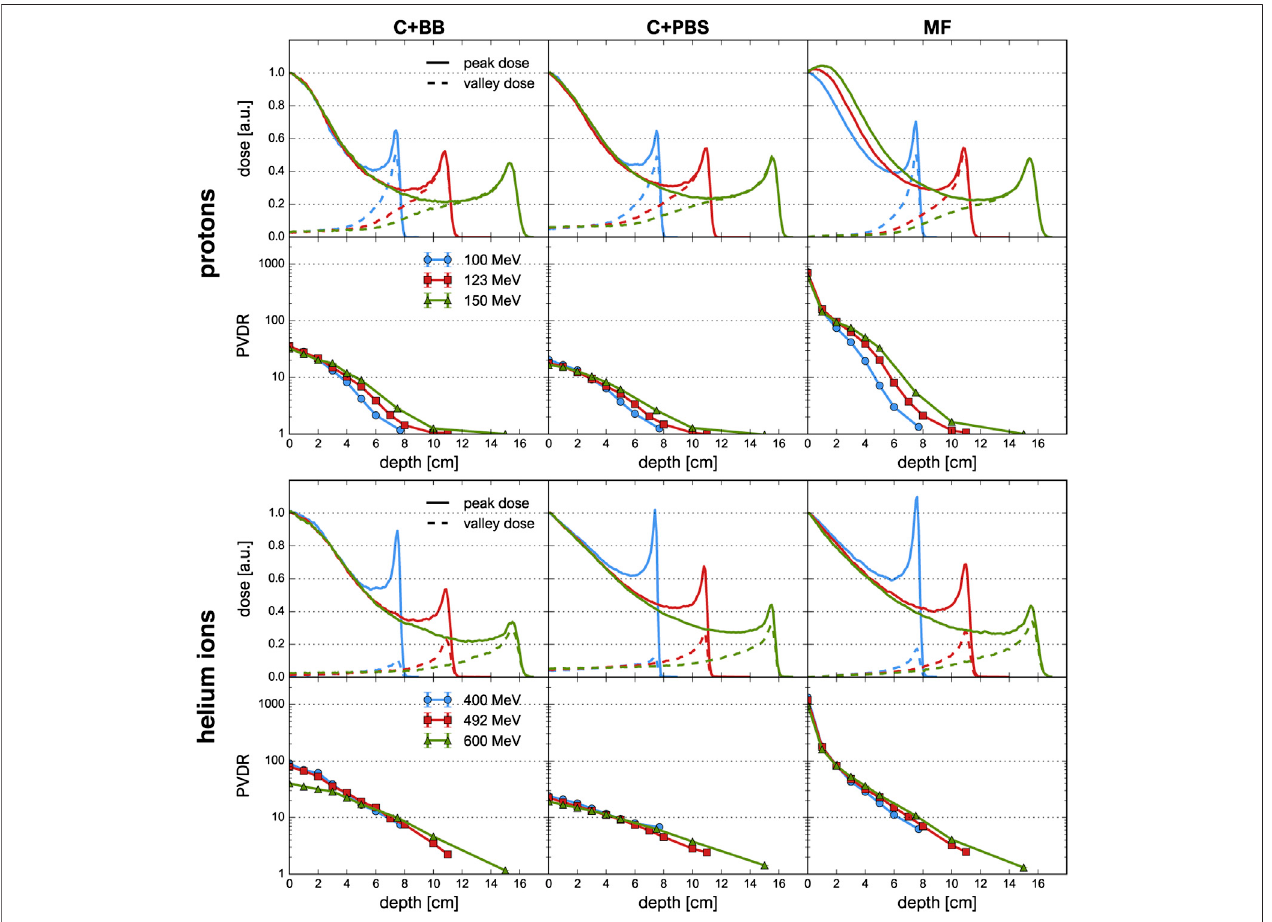
FIGURE 5 | Depth-dose pro fi les and PVDR evolution for proton and helium ion beams and for the different minibeam techniques (columns). First and third row: depth-dose pro fi les along peak (solid lines) and valley (dashed lines) regions. Second and fourth row: Evolution of PVDR as a function of depth, the uncertainty bars are smaller than the markers.